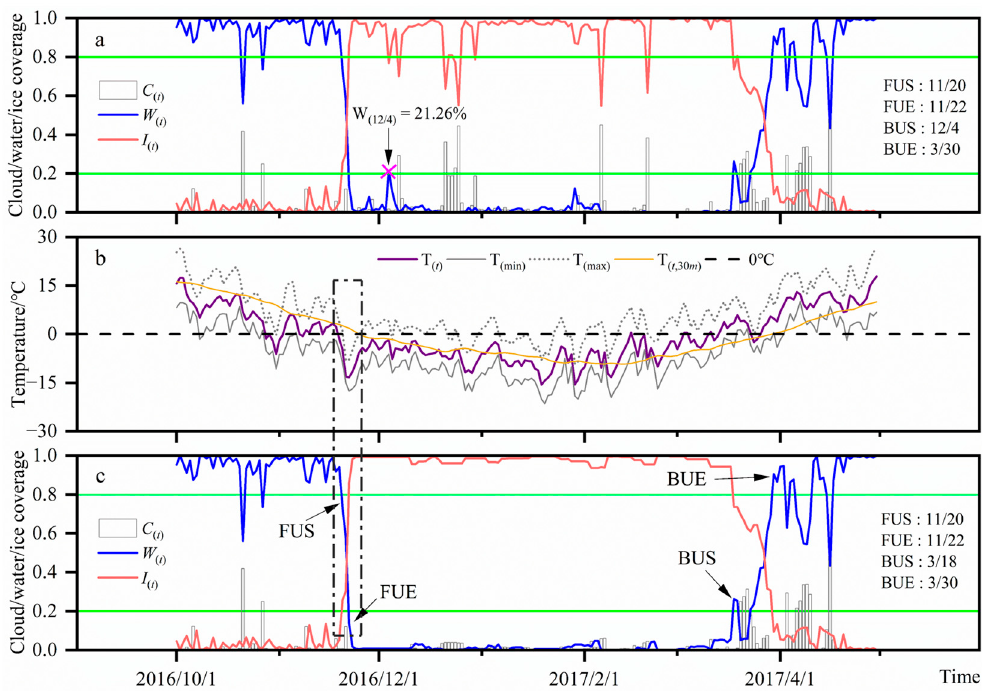
Figure 7. Daily cloud/water/ice coverage and air temperatures in Wuliangsu Lake in 2017. ( a ) Without temperature correction. ( b ) Daily mean air temperature ( T ( t ) ), daily minimum air temperature ( T (min) ), daily maximum air temperature ( T ( max ) ), and mean air temperature of the previous 30 days ( T ( t ,30 m ) ) after calculating at the meteorological stations near Wuliangsu Lake. ( c ) With air temperature correction. (The two green lines indicate the two thresholds for extracting ice phenology dates, and the four arrows from left to right indicate freeze-up start (FUS), freeze-up end (FUE), break-up start (BUS), and break-up end (BUE), respectively).